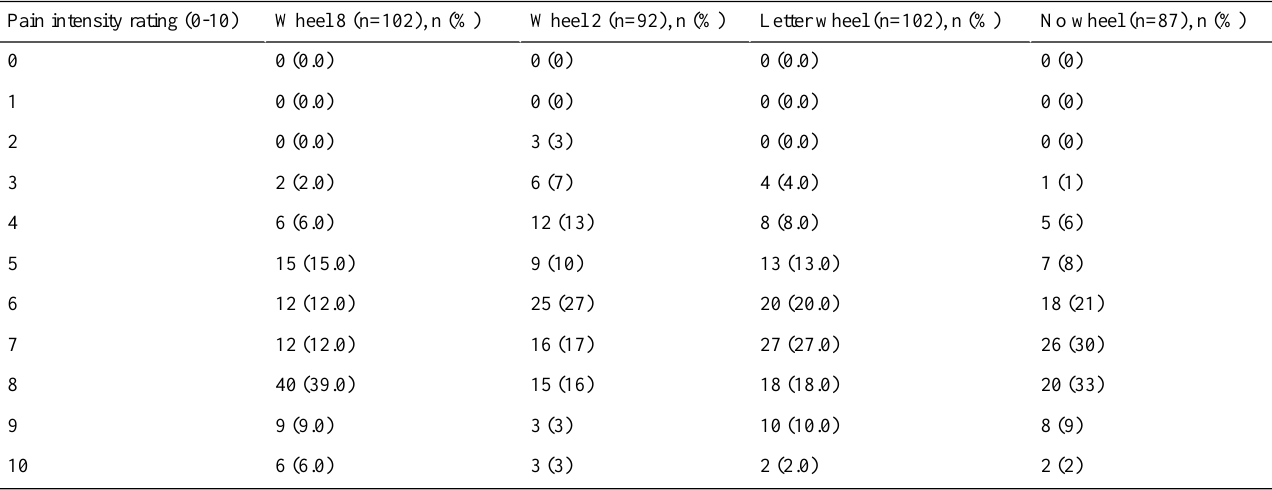
Table 2. Frequency (percent) of pain intensity ratings for the four